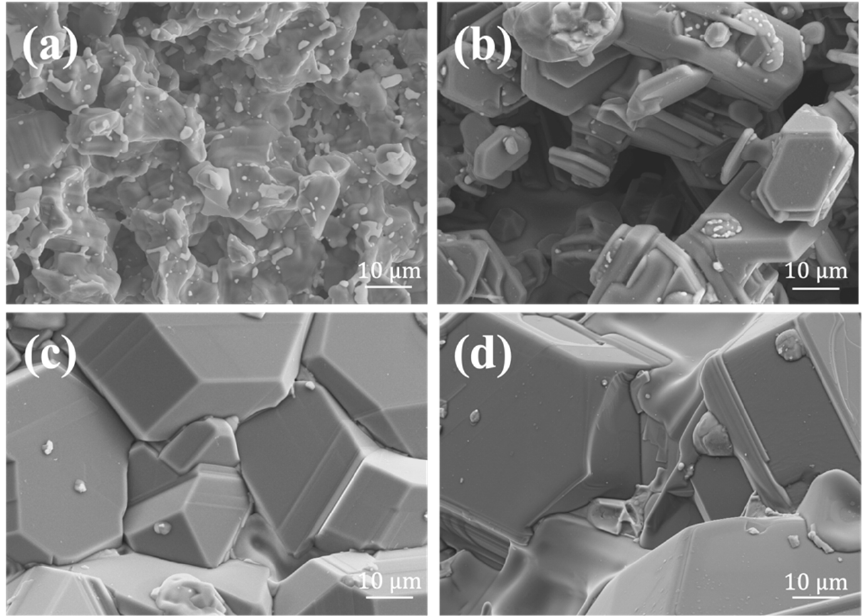
Figure 2. SEM images of the surface of SiC/MoSi 2 -SiC-Si coatings with different Si/Mo ratio: ( a ) 1:1, ( b ) 3:1, ( c ) 5:1, ( d ) 7:1.